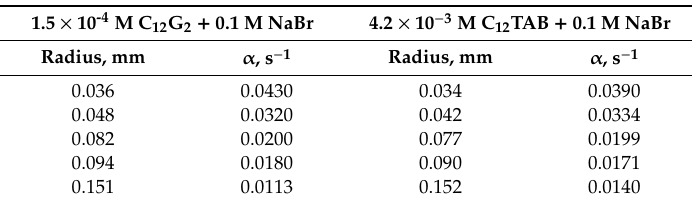
Table A2. Data of experimentally determined drainage coe ffi cient for films obtained from two solutions, 1.5 × 10 − 4 M C 12 G 2 with 0.1 M NaBr and 4.2 × 10 − 3 M C 12 TAB with 0.1M NaBr. Table 1. Data of experimentally determined drainage coefficient for films obtained from two 318 solutions, 1.5 ×10 − 4 M C 12 G 2 with 0.1 M NaBr and 4.2×10 − 3 M C 12 TAB with 0.1M NaBr. 319